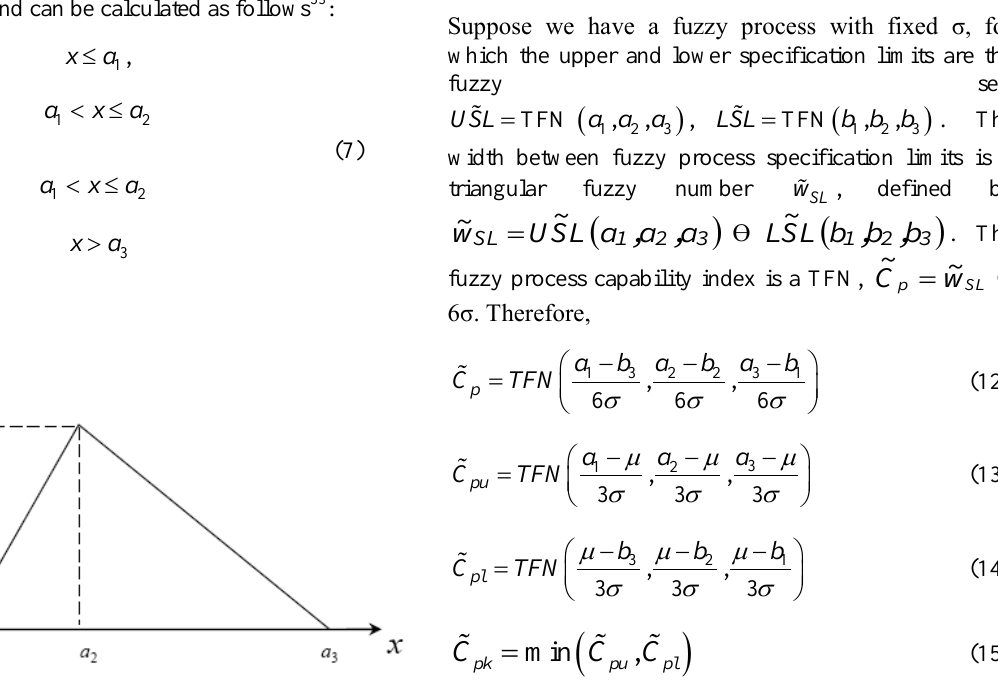
Figure 2. A triangular fuzzy number